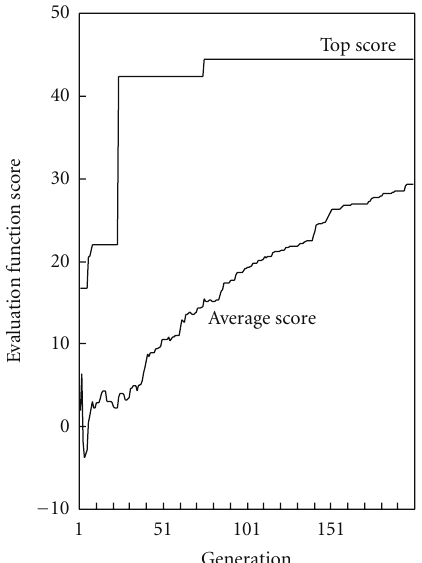
Figure 3: Evaluation function score in the evolutionary computa-